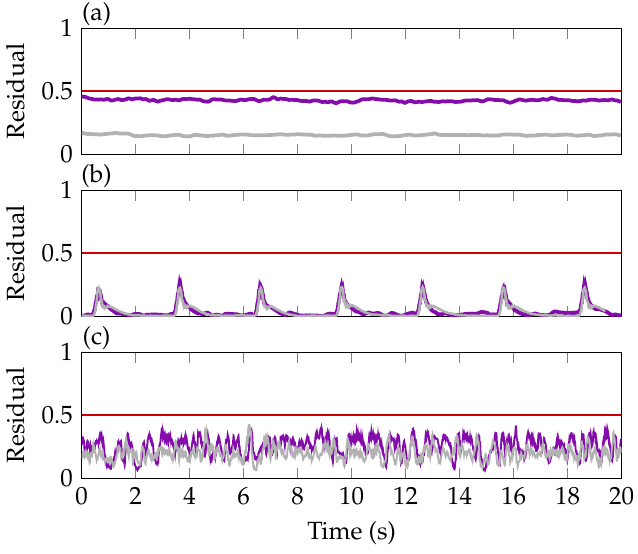
Figure 12. Residual signals during open-loop ( ) and closed-loop ( ) experiments for sinusoidal excitation ( a ), 1-cosine gust excitations ( b ) and noise excitations ( c ) compared to the threshold ( ).